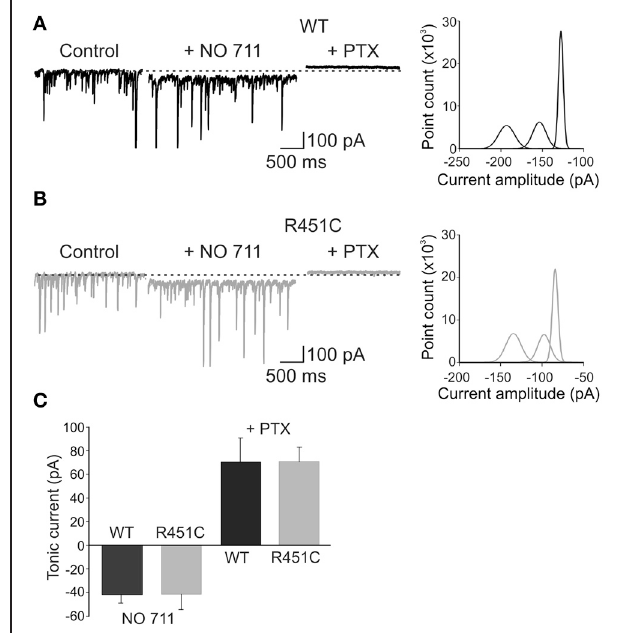
FIGURE 7 | The NL3 R451C knock-in mutation does not alter GABA transporters and tonic GABA A -mediated inhibition. (A) Left: representative traces of spontaneous GPSCs recorded in a P 12 pyramidal cell in hippocampal slice obtained from a WT animal before (Control), during application of the GAT-1 blocker NO-711 (10 μ M) and NO-711 plus picrotoxin (100 μ M). Right: all-point histogram of 10ms traces from the cell recorded on the left in control conditions, in the presence of NO-711 and NO-711 plus picrotoxin. (B) As in (A) but from NL3 R451C KI mutant mouse. (C)